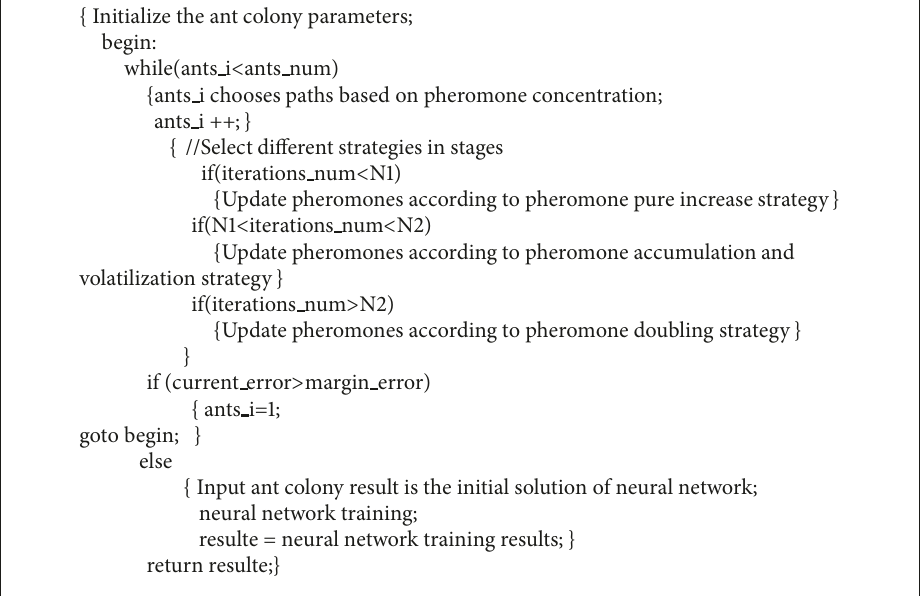
Algorithm 1: IACO-BP (improved ant colony optimization